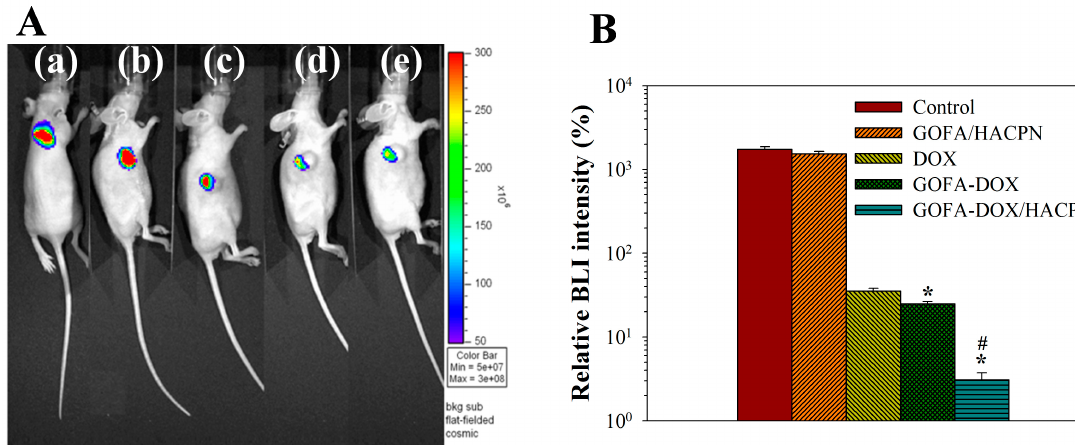
Figure 12. The bioluminescence imaging (BLI) of subcutaneously implanted MCF-7/Luc cells in nude mice. The BLI signal was measured at baseline (before treatment) and at day 21 after treatment. ( A ) Representative BLI obtained in the ( a ) control (saline), ( b ) GOFA/HACPN, ( c ) DOX, ( d ) GOFA-DOX and ( e ) GOFA-DOX/HACPN group by IVIS at day 21. ( B ) Plot of the relative BLI signal intensity at day 21 (mean ± SD, n = 6). The relative BLI signal intensity (%) was calculated from the total bioluminescent signal intensity at day 21 normalized by the total bioluminescent signal intensity at baseline. * p < 0.05 compared with DOX, # p < 0.01 compared with GOFA-DOX.